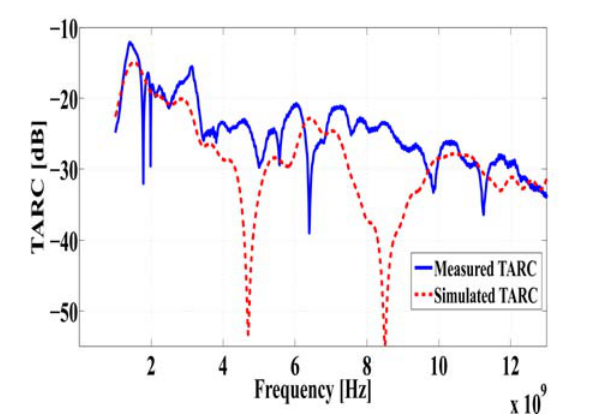
FIGURE. 14 Measured and Simulated Total Active Reflection Coefficient